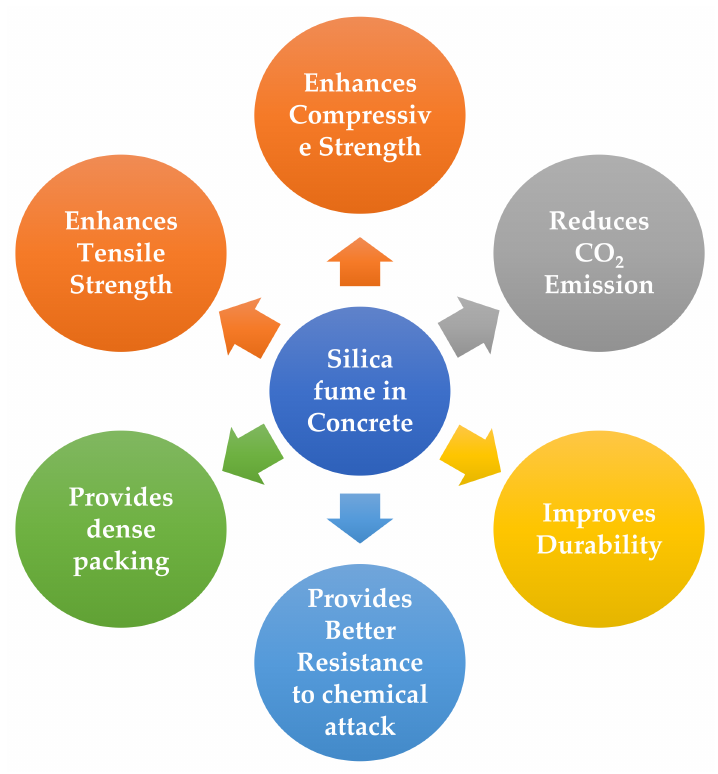
Figure 1. Silica fume benefits in